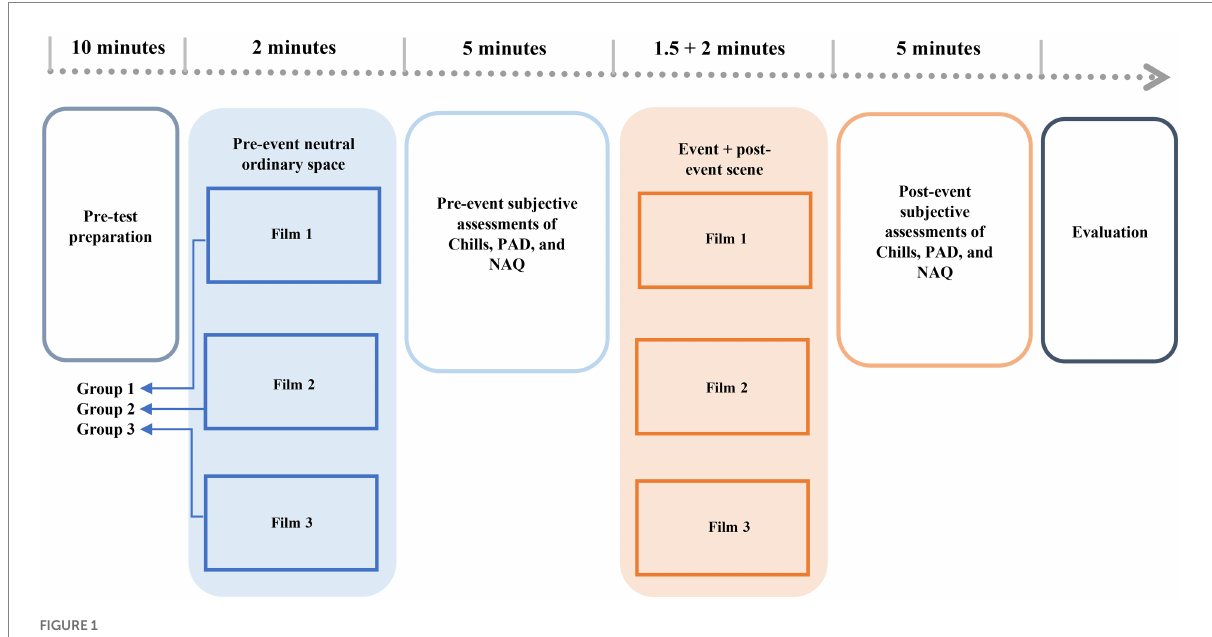
FIGURE 1 Research